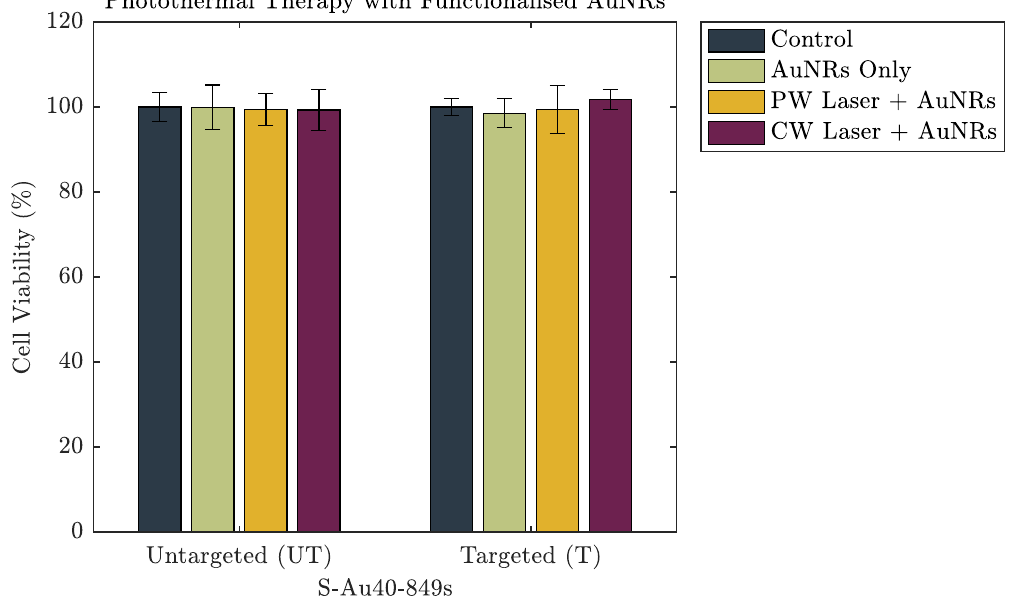
Figure 6. The cell viability of a lung cancer cell line after 4h incubation with either untargeted S-Au40-849s or targeted